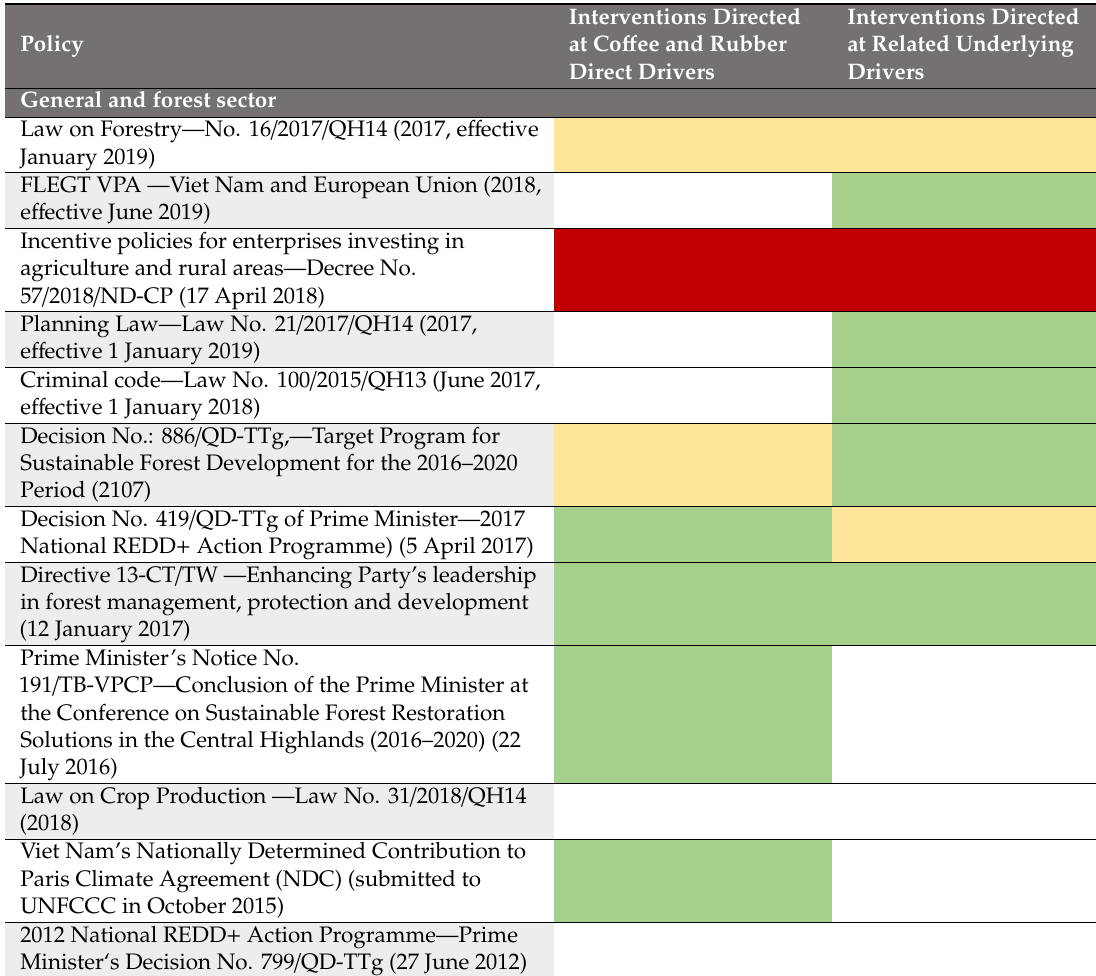
Table 3. The degree to which policies and laws related to National REDD + Action Plan (NRAP) implementation include interventions aimed at direct and underlying